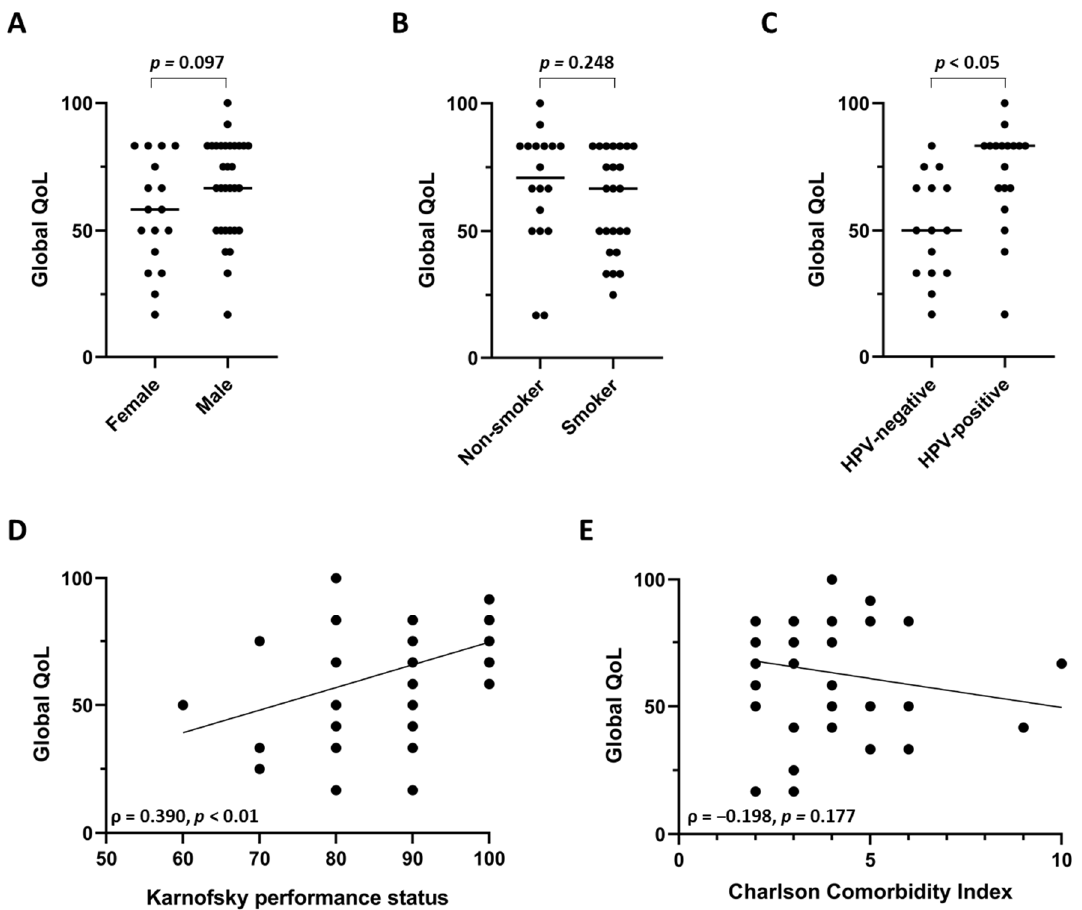
Figure 2. Global QoL of surviving elderly HNSCC patients undergoing (chemo)radiotherapy in terms of patients’ gender ( A ), smoking status ( B ) and HPV status ( C ). Correlation between global QoL and Karnofsky performance status ( D ) or Charlson Comorbidity Index ( E ). ( A – C ) Each scatter plot represents one patient, and the line shows the median value. Groups were compared using Mann-Whitney U tests. ( D , E ) Spearman’s rho with the corresponding p -value is indicated for the correlation analyses. The line shows the regression line of the xy-matrix.